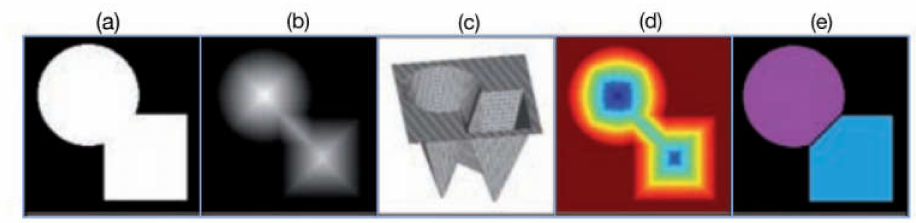
Figure 3. Sample segmentation using the watershed method [25]: ( a ) original binary image; ( b ) grayscale distance image; ( c ) topological surface; ( d ) depth contours; ( e ) detected pores separated by the watershed ridge